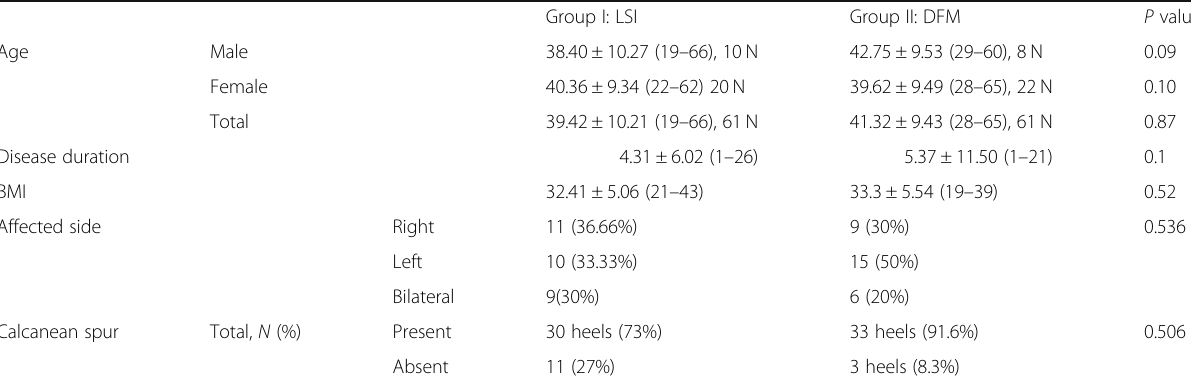
Table 1 Demographic and clinical findings of patients